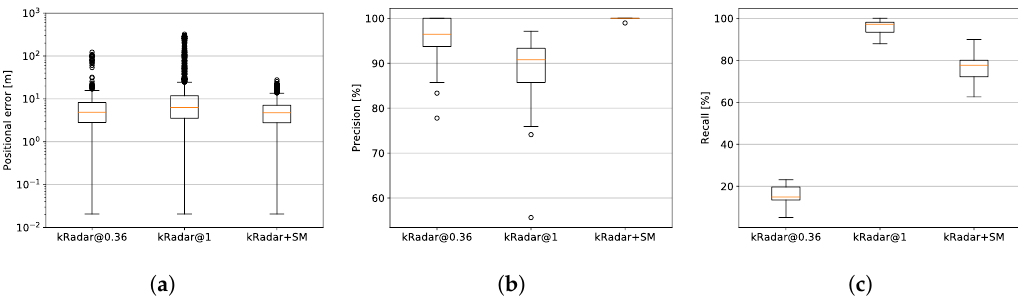
Figure 12. Statistics for positional error ( a ), precision ( b ), and recall ( c ) for the proposed system and the two considered baselines. As described in Section 5.2, there is a bias in these errors (of approximately 10m) attributed to the manual alignment of the groundtruth odometry traces. Despite this, our proposed system is shown to exhibit tighter variance over the course of this